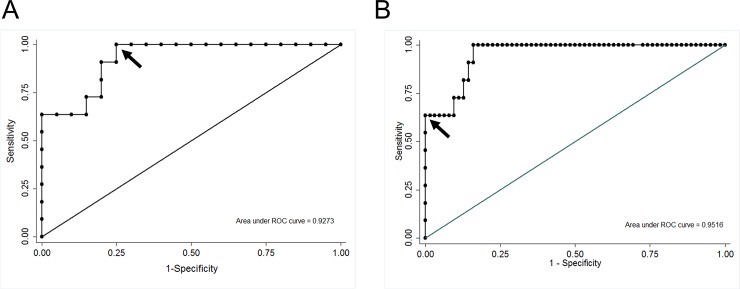
Receiver operating curve (ROC) analysis: A) To discriminate between RAS and BOS by KL-6 serum levels. The arrow indicates the cut-off value of 465 U/mL which gives a 100% sensitivity and 75% specificity for the test with a positive predictive value of 69% and a negative predictive value of 100%. B) To discriminate between RAS and the whole LT population. The arrow indicates the cut-off value of 800 U/mL which gives a 64% sensitivity and 97% specificity for the test with a positive predictive value of 78% and a negative predictive value of 94%.